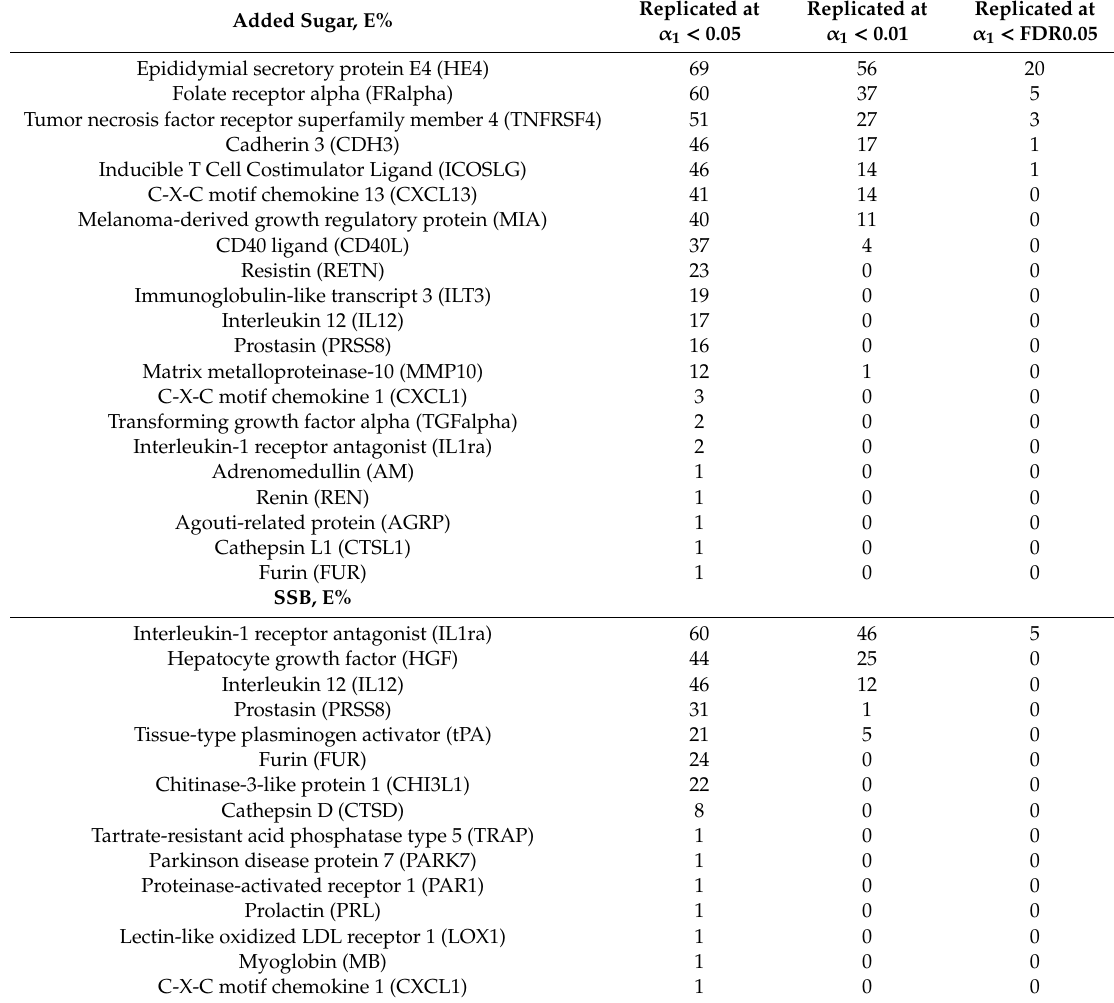
Table 3. The number of times proteins associated with added sugar intake and SSB intake, respectively, out of 100 iterations of random discovery and replication cohorts at various α 1 levels using a TSIR approach. A protein must be replicated at least 20 times to pass internal